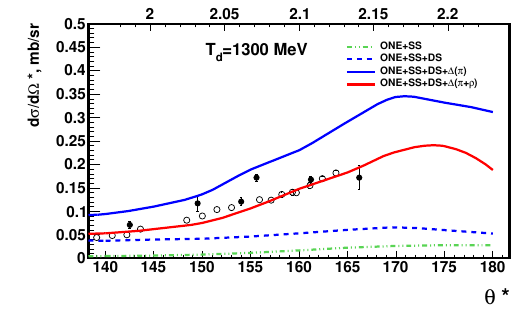
Figure 5: The angular dependence of the differential = 1200 MeV. cross section at the deuteron energy T d The data are from ◦ - [ 22 ] at T = 1200 at T d